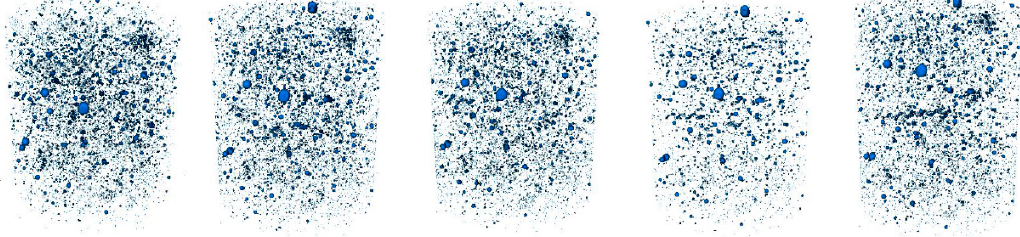
Figure 4. Histograms of grey scale. Figure 5. Three-dimensional (3D) views of the voids belonging to plain concrete at different ages. Age increases from left to right .